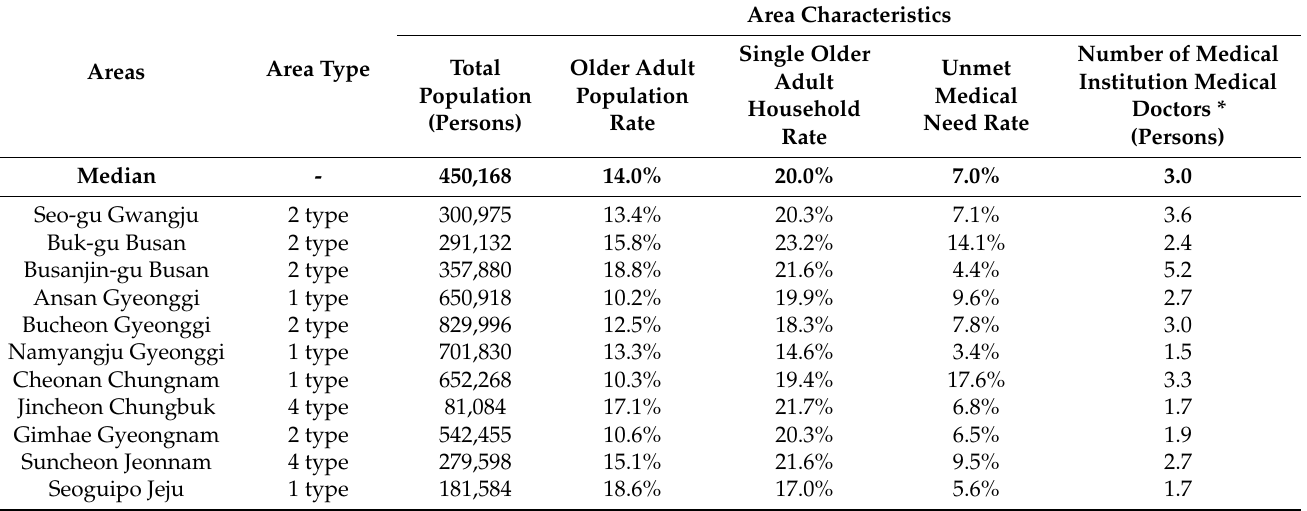
Table 1. Demographics of participant’s